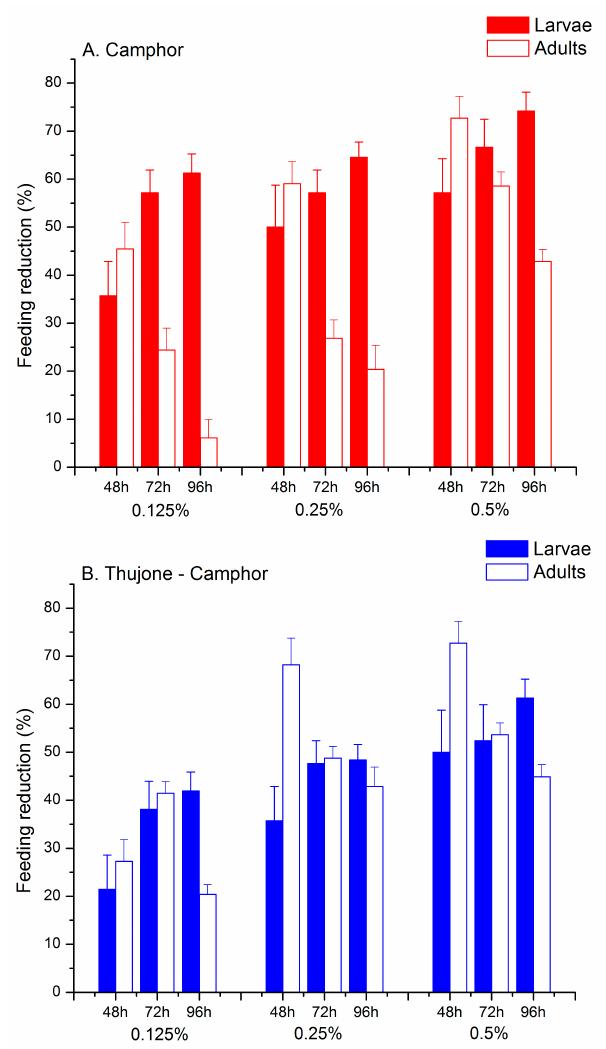
Figure 2. Feeding reduction index in CPB larvae and adults exposed to pure camphor ( A ) and the thujone-camphor mixture ( B ) at three different concentrations. Table 2. Repeated measures ANOVA of the feeding reduction index during 48–96 h of exposure of CPB larvae and adults to different concentrations of camphor and the thujone-camphor mixture. Significant effects are given in bold.